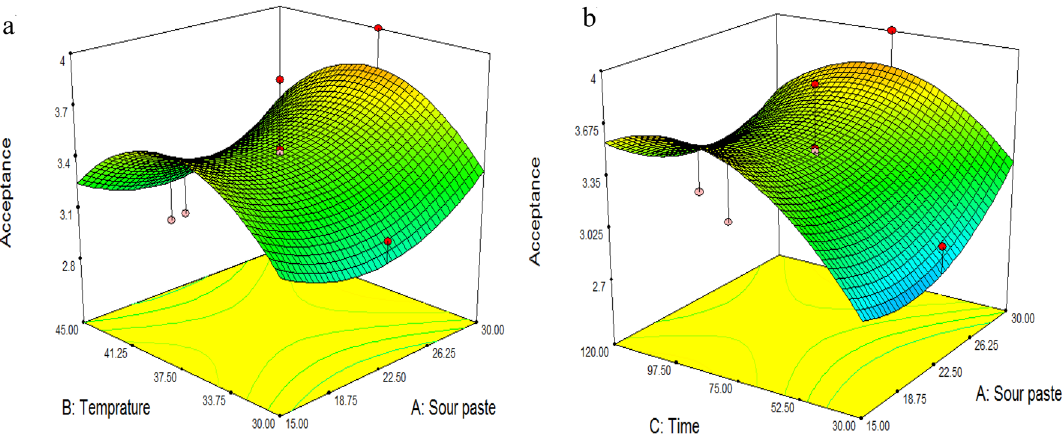
Fig. 5 Effect of temperature and sourdough amount a and fermentation time and sourdough amount b on overall acceptance of Barbari bread